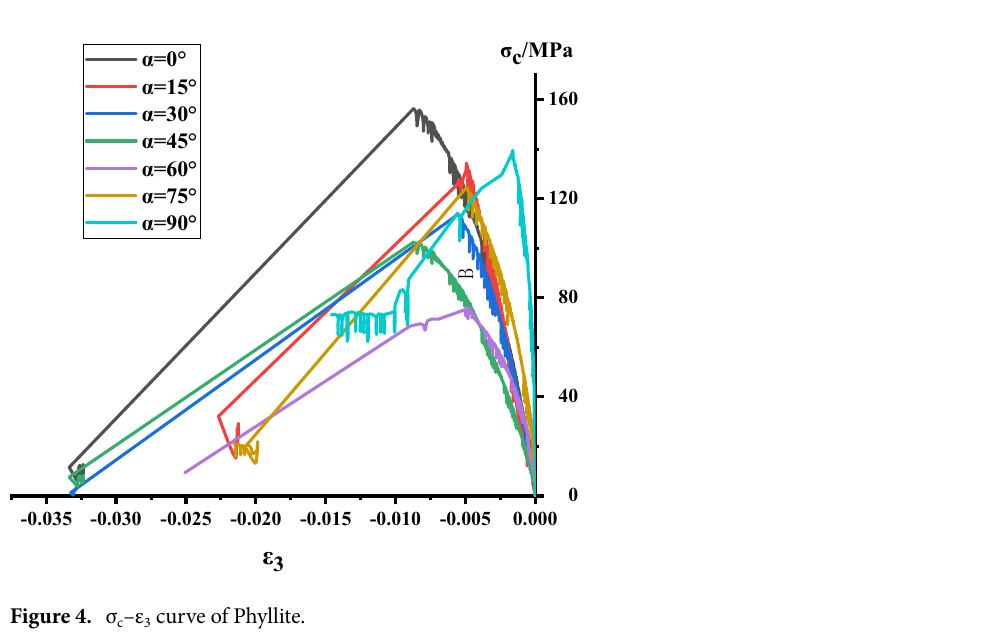
Figure 4. σ c –ε 3 curve of